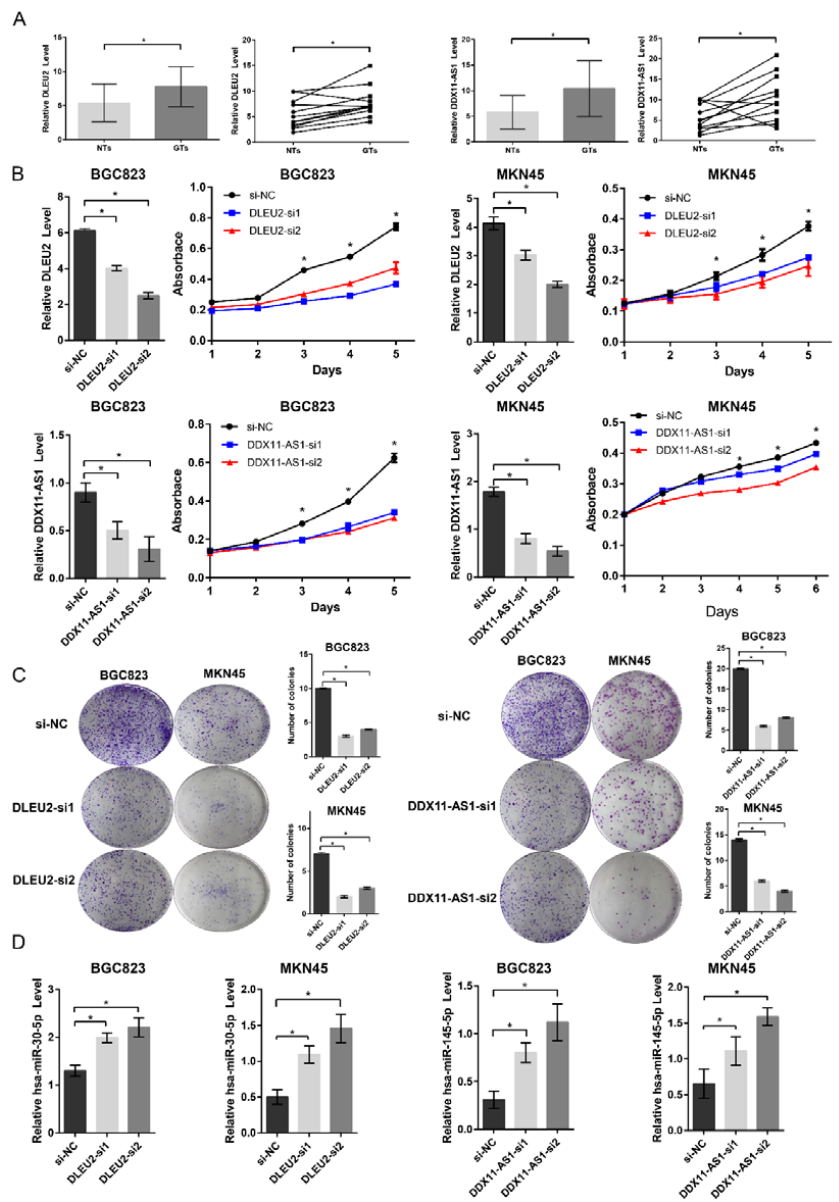
Figure 6. Functional validation of the predicted hub lncRNAs in GC. ( A ) The qRT-PCR results showed that the expression levels of DLEU2 and DDX11-AS1 in 12 pairs of GC tissues (GTs) were significantly higher than the adjacent normal tissues (NTs); ( B ) The qRT-PCR results showed DLEU2 and DDX11-AS1 knockdown in BGC823/MKN45 cells after transfection with NC (negative control), siRNA 1 (si-1), and siRNA 2 (si-2). The CCK-8 assays showed that knockdown of DLEU2 and DDX11-AS1 suppressed cell proliferation in BGC823/MKN45 cells; ( C ) The colony-forming assays showed that knockdown of DLEU2 and DDX11-AS1 suppressed cell proliferation in BGC823/MKN45 cells; ( D ) In BGC823 and MKN45 cells, knockdown of DLEU2 and DDX11-AS1 increased hsa-miR-30-5p and hsa-miR-145-5p expression, respectively. Biological experimental results were analyzed using paired or unpaired t -test, * denotes p <